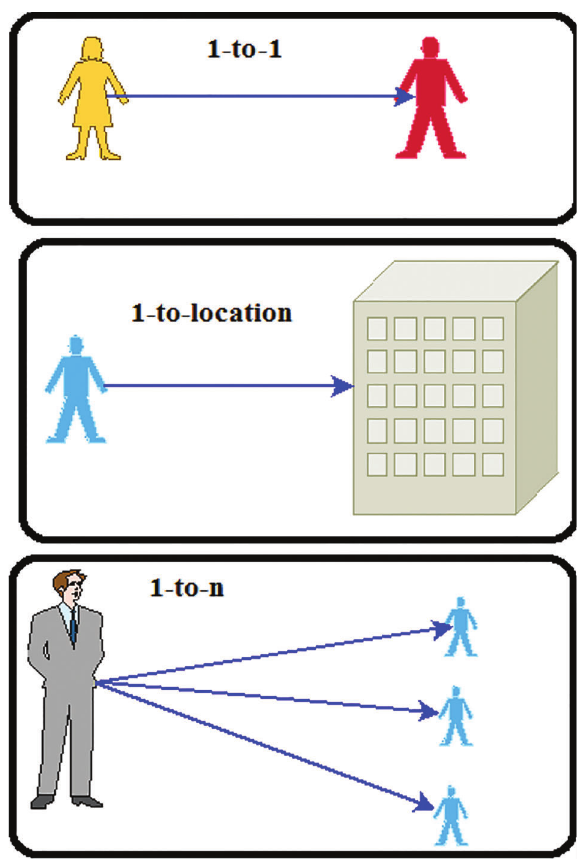
Figure 3. Different types of agents ’